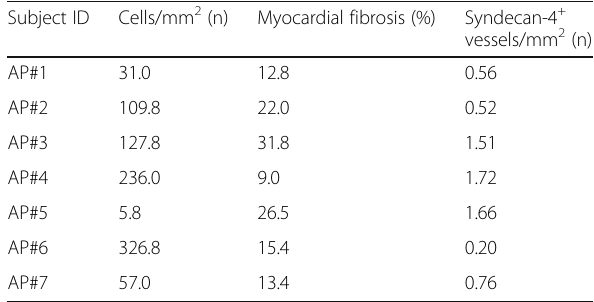
Table 1 Assessment of number of inflammatory cells, percentage of myocardial fibrosis and expression of